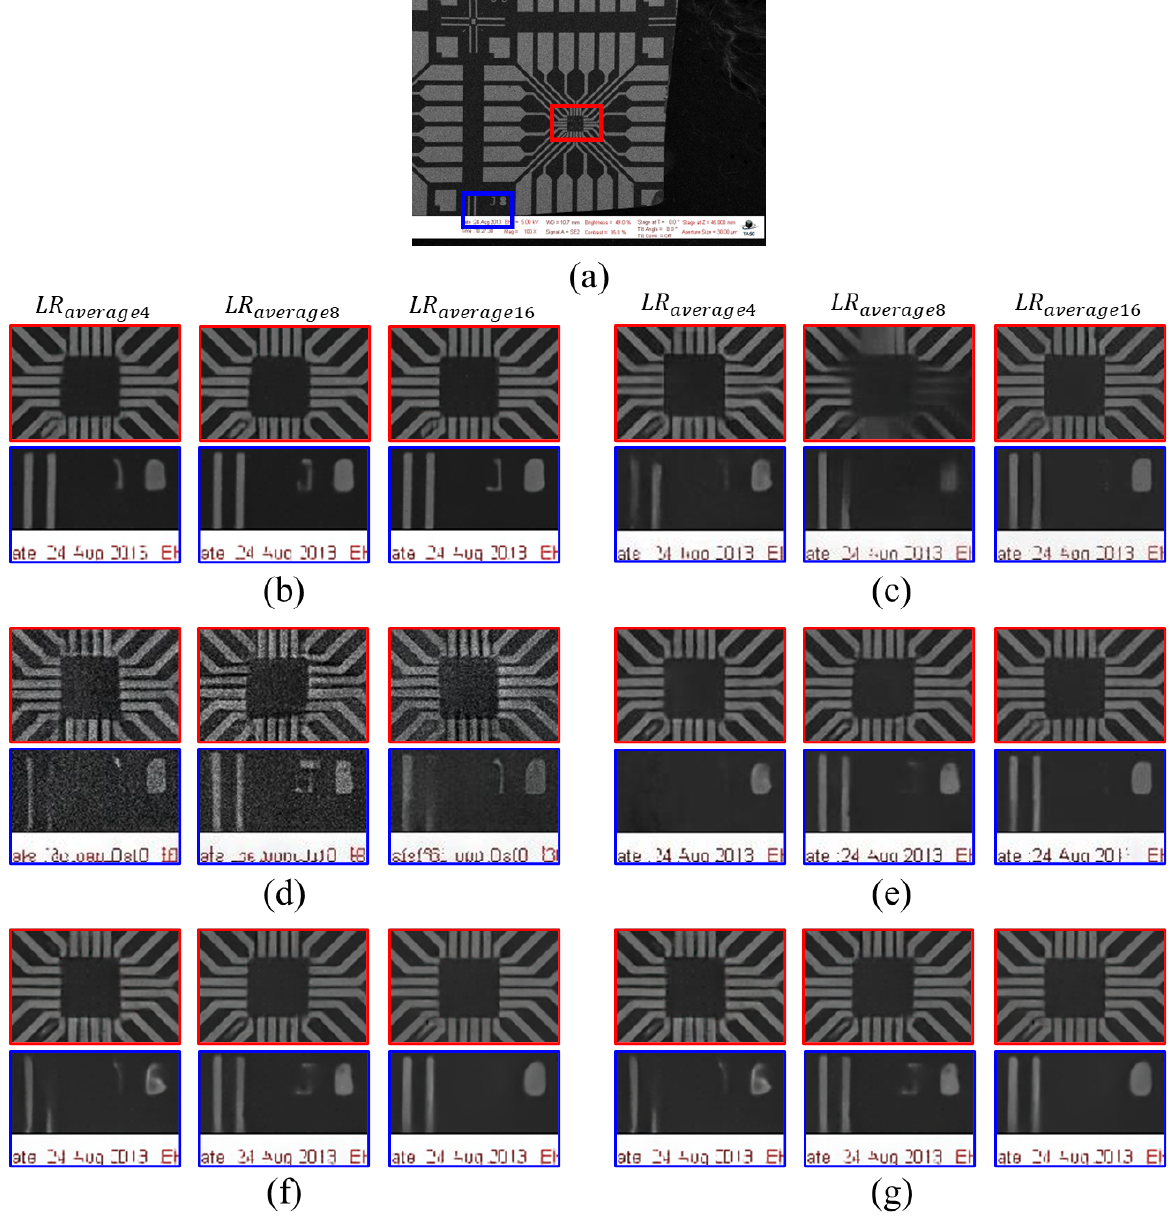
Figure 8. Qualitative comparison with conventional SR methods: ( a ) full-resolution image is the HR target image, which is given as a reference for the position of the magnified boxes; ( b ) SwinIR [26], ( c ) RCAN [9], ( d ) ESRGAN [12], ( e ) MSRResNet [11], ( f ) LTE [30], and ( g ) HAN [31]. For fair comparison, noise variance for LR average is set to